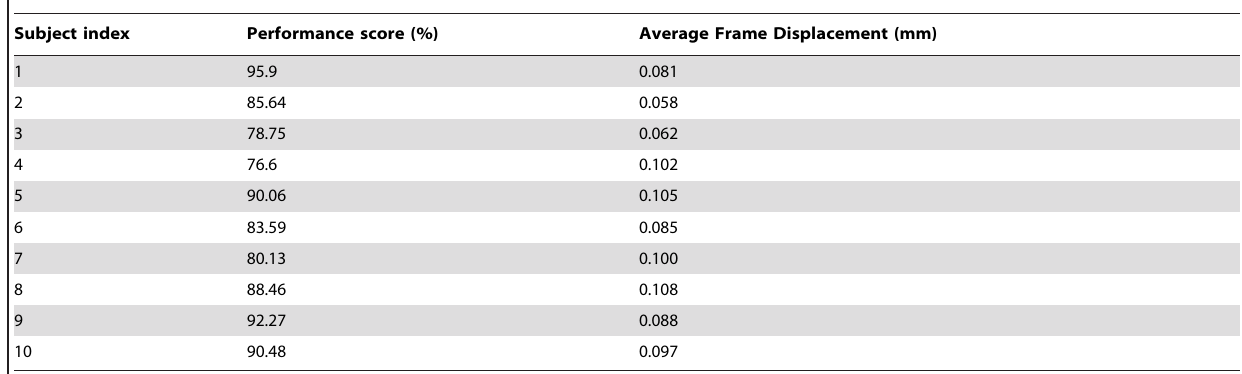
Table 1. Performance scores and head motion of the individual